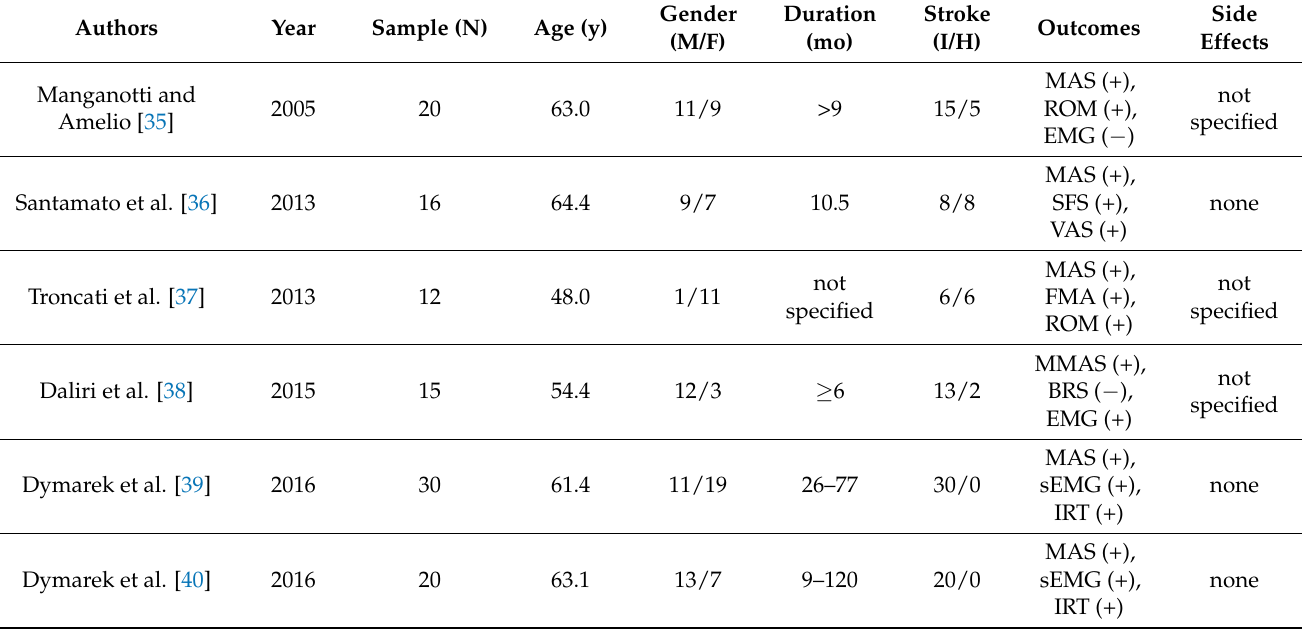
Table 1. Upper limb—characteristics of patients and outcomes.